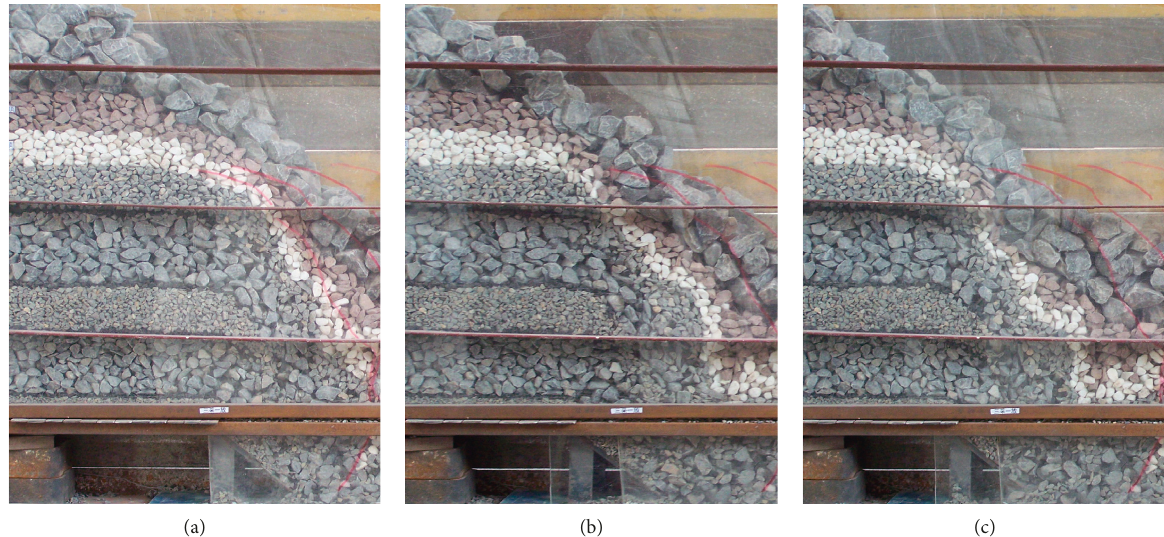
Figure 18: Dump top coal effect of three knife one falling. (a) Before relocation. (b) After relocation and before coal dumping. (c) After laying coal.